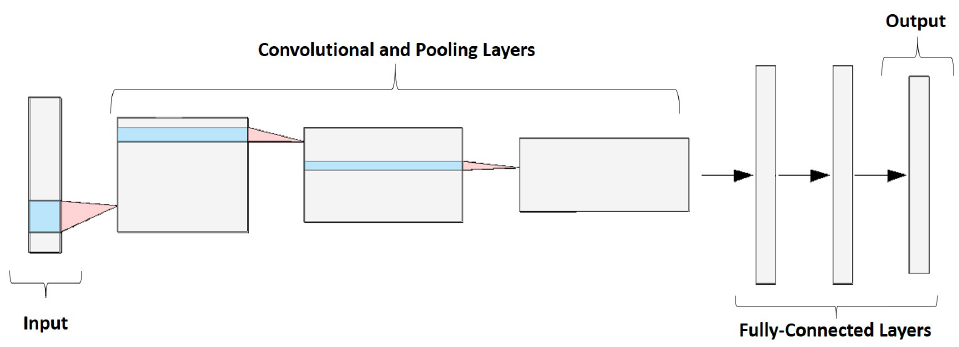
Figure 1. Example of a sequential convolutional neural network (CNN) architecture. The figure was generated using NN-SVG [21].